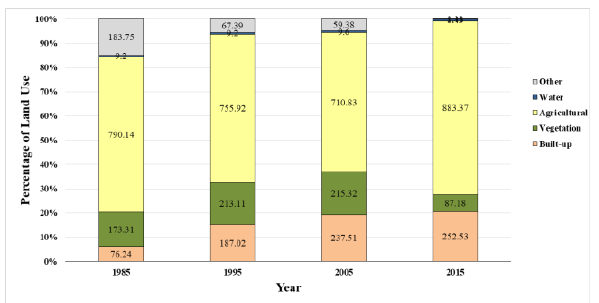
Figure 4. Magnitude of Land use change in study area